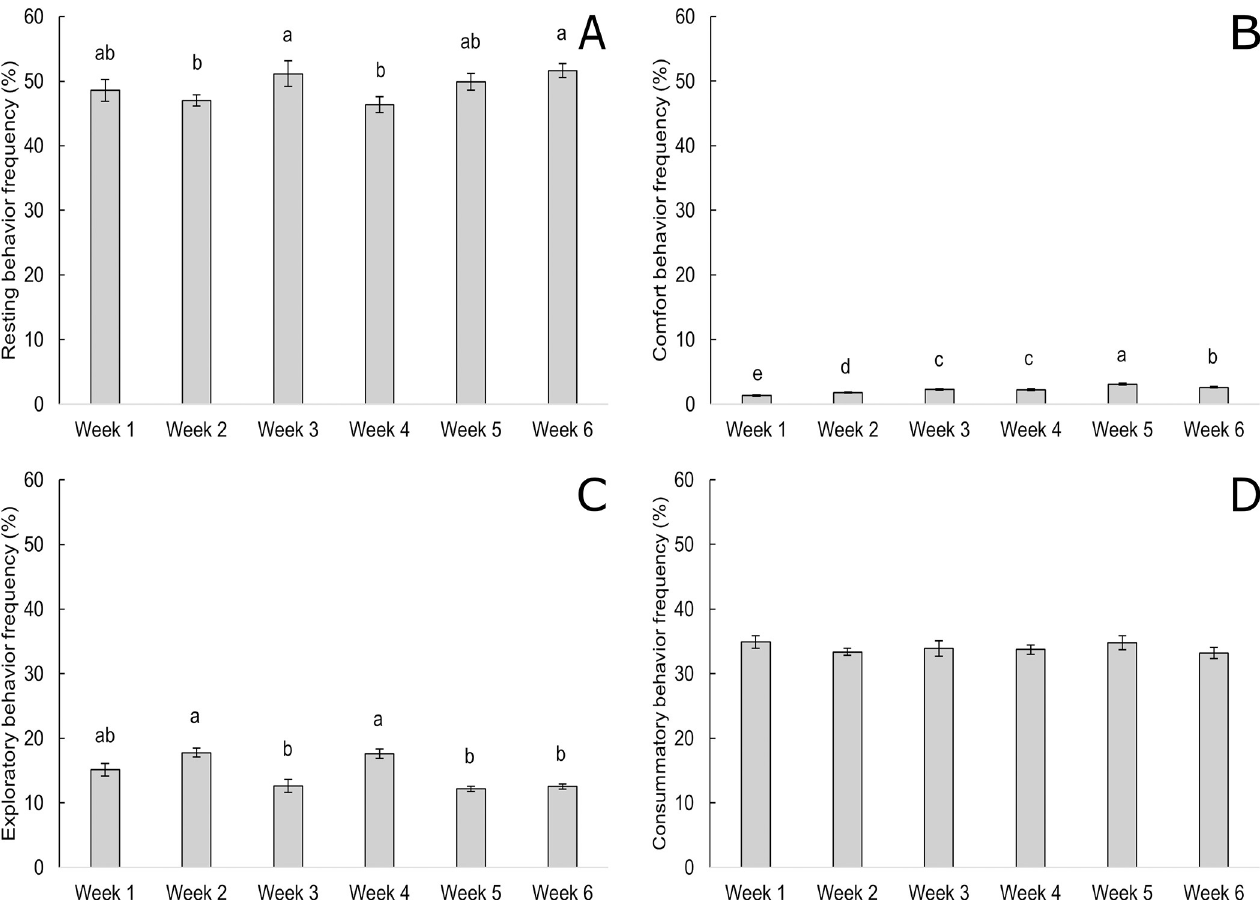
Fig 4. Frequency of observations (mean % ± SEM) of each behavioral category by chicken age (in weeks) across two time periods (09:00 and 15:00 h), n = 192 observations. Frequencies of (A) resting behavior, (B) comfort behavior, (C) exploratory behavior, and (D) consummatory behavior. Means within a behavioral category without a common superscript ( a–e ) differed at P <